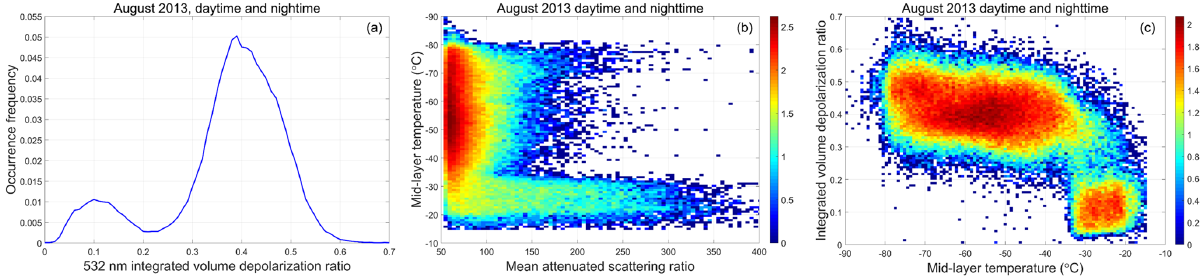
Figure 4. Panel (a) shows the occurrence frequencies of layer-integrated volume depolarization ratios for all calibration clouds identified by the V3 algorithm during August 2013, panel (b) shows the joint distribution of layer-integrated volume depolarization ratios and layer mean attenuated scattering ratio, and panel (c) shows the joint distribution of layer-integrated volume depolarization ratios and mid-layer temperatures. The colors in panels (b) and (c) indicate log 10 of the number of samples per